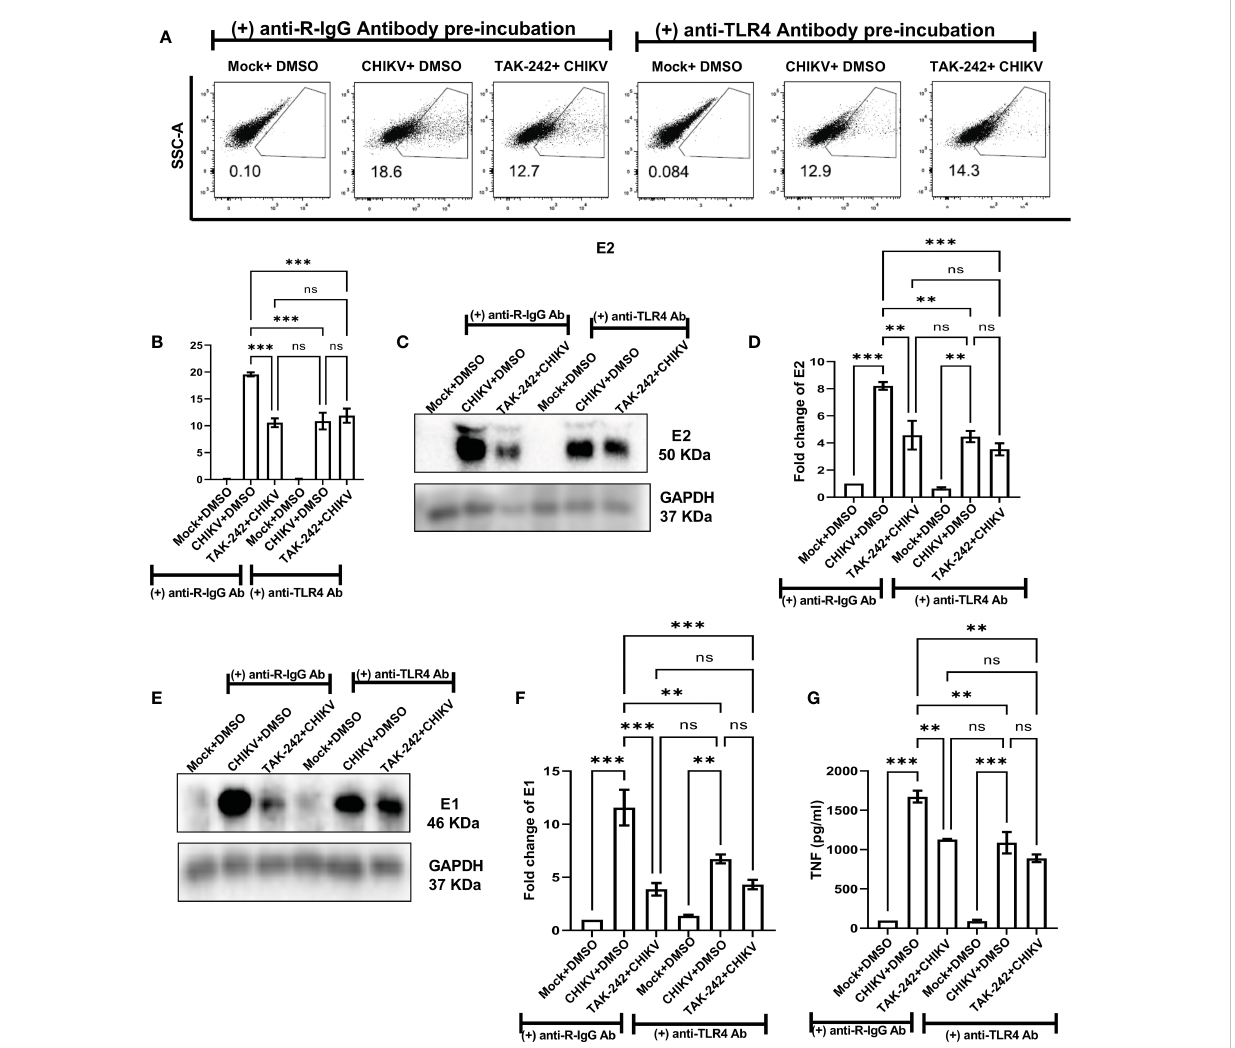
FIGURE 5 Pre-incubation with anti-TLR4 antibody alleviates CHIKV infection in host RAW264.7 macrophages, in vitro . Before pre-incubation of the RAW264.7 cells with either DMSO or TAK-242, the anti-TLR4 antibody or anti-R-IgG antibody was added in the pre-incubation volume in respective conditions at 4 m g/ml concentration and the cells from all conditions were preincubated for 3 h. The CHIKV infection was given at 5 MOI for 2 h and the cells were harvested at 8 hpi. (A, B) The fl ow cytometry dot plot analysis shows comparative CHIKV-E2 levels at different conditions. (C, D) Western blot analysis shows E2 expression in different experimental conditions. (E, F) Western blot analysis shows differential E1 expression. All densitometric quanti fi cations were performed with respect to GAPDH. (G) The bar diagram represents ELISA-based cytokine analysis of